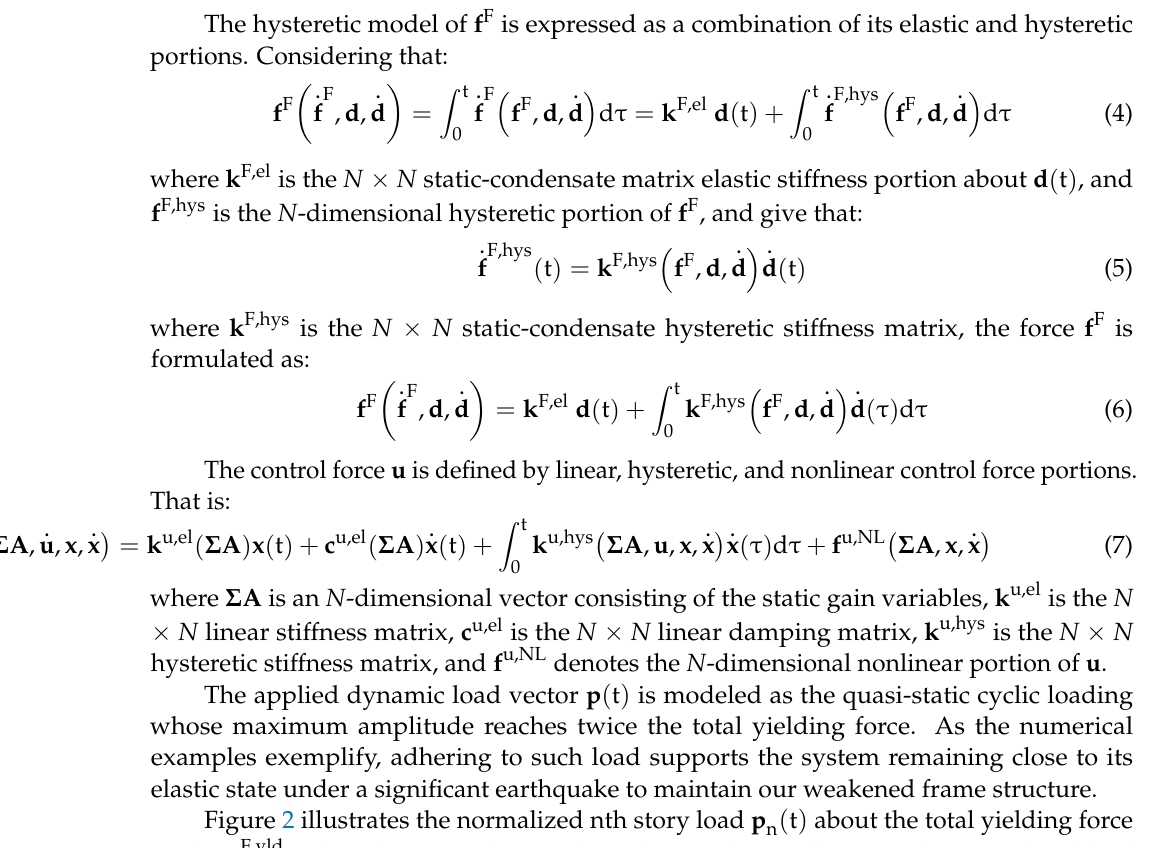
Figure 1. Rigid frame system deformations in terms of relative-to-ground displacements (x 1 ,x 2 , . . . ,x N − 1 ,x N ) and interstory drifts (d 1 ,d 2 , . . . ,d N − 1 ,d N